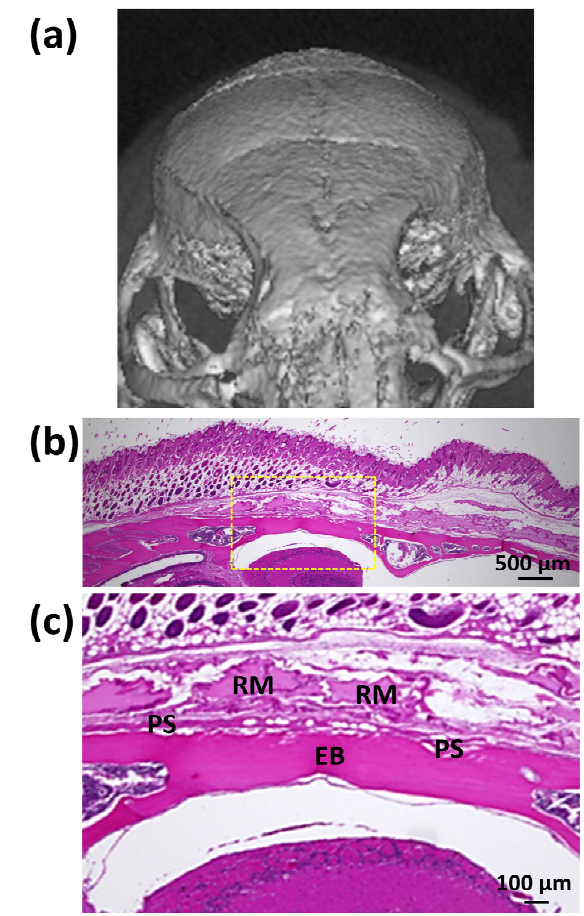
Figure 14. ( a ) Front micro-CT image of one mouse cranial bone 8 weeks after control SG I (SG I*nHAp ( − )) was injected into the cranial connective tissue; ( b ) the low magnified HE-stained image of the cranial subcutaneous tissue of a mouse 8 weeks after injection of SG I (SG I*nHAp ( − )) material; and ( c ) the high-magnified HE image of the yellow rectangle area of Figure 14b. Note: RM, residual material; PS, periosteum; EB, existing bone.